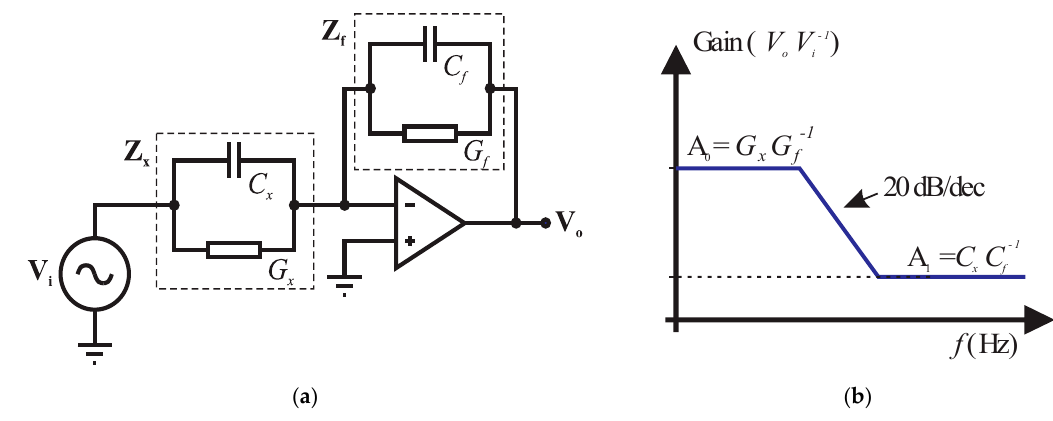
Figure 1. ( a ) I-V converter circuit and ( b ) frequency domain response.